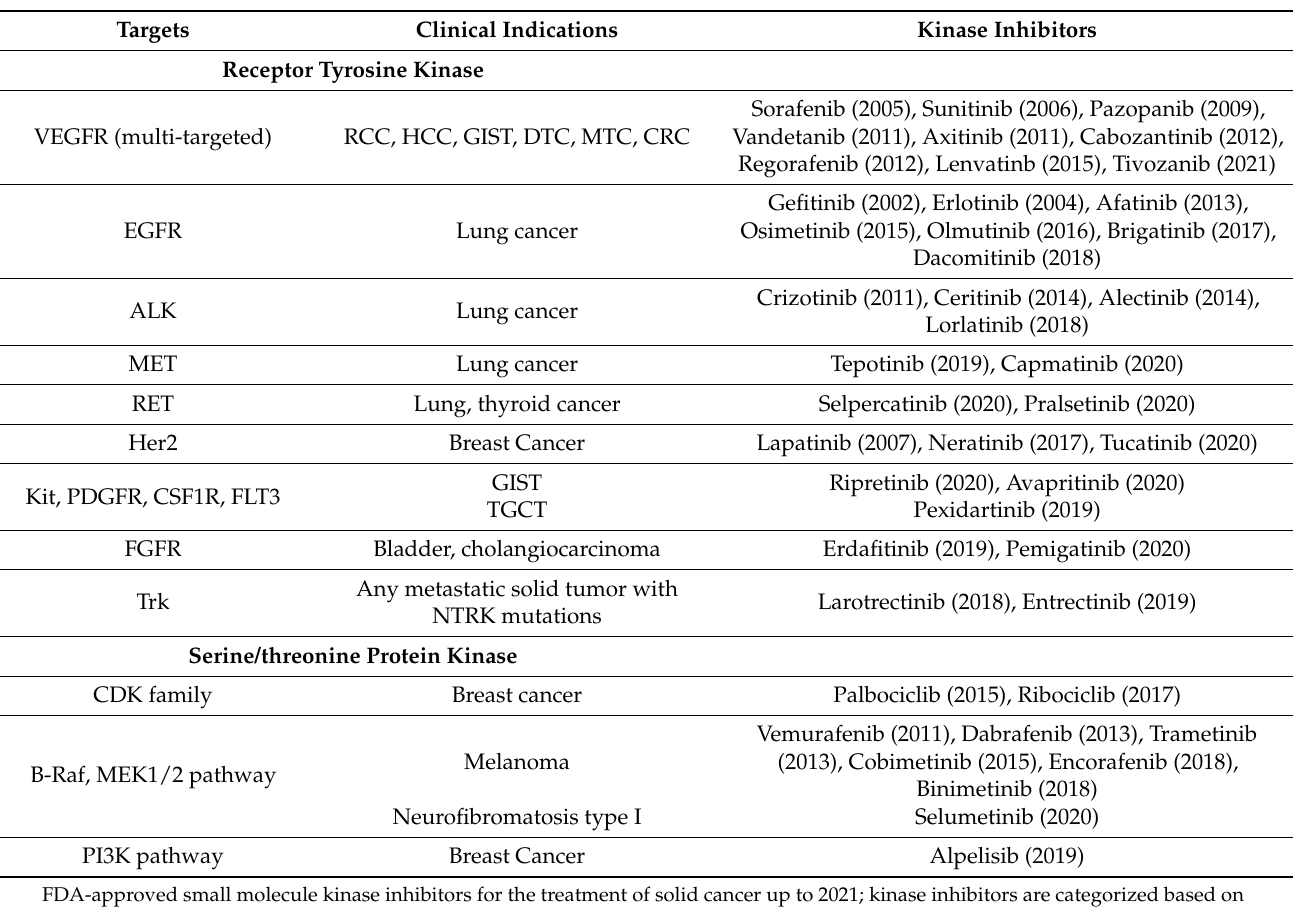
Table 1. List of FDA-approved kinase inhibitors for solid